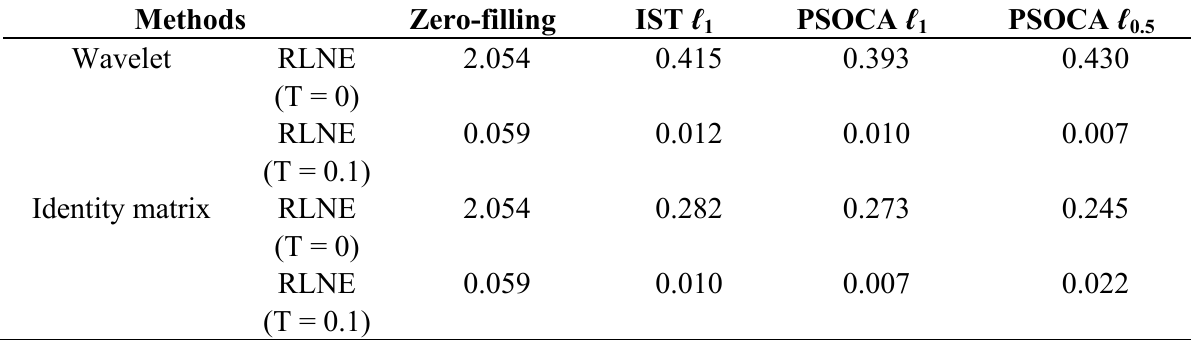
Table 1. Reconstruction error of a 1 H- 1 H COSY